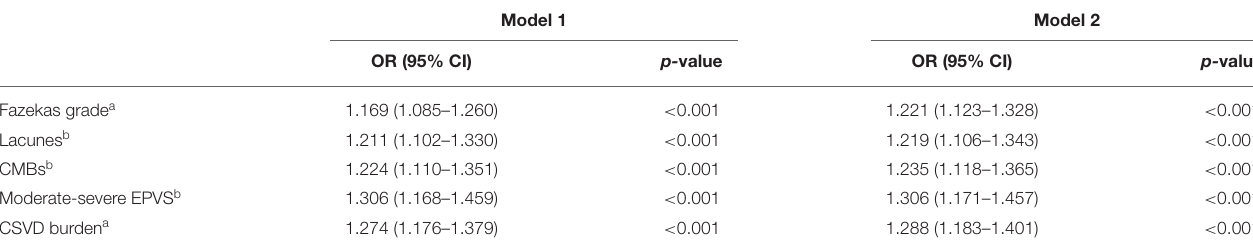
Model 1: adjusted for age and sex. Model 2: adjusted for age, sex, BMI, SBP, DBP, current smoking, current drinking, TC, HbA1c, HAMA, HAMD. a Ordinal logistic regression. b Binary logistic